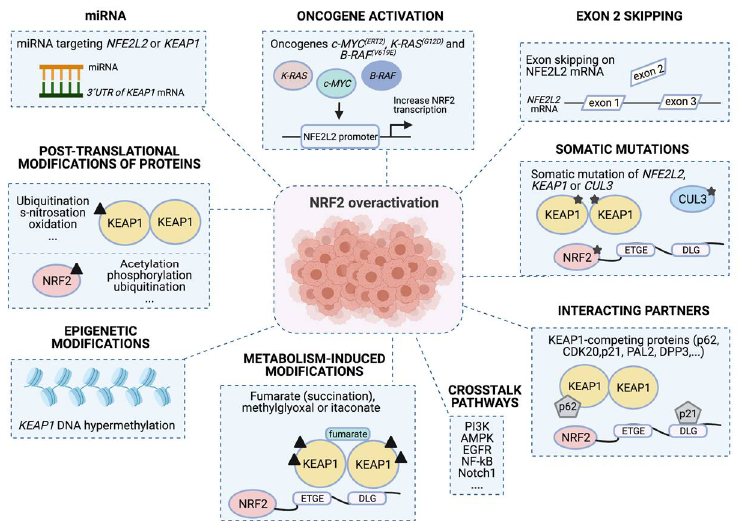
Figure 6. Molecular mechanisms confer NRF2 addiction. Different mechanisms can contribute to promote NRF2 over-activation. First, somatic mutations on NFE2L2/KEAP1/CUL3; second, differential slicing and loss of exon 2 during mRNA processing; third, mutations in other oncogenes, such as c-MYC (ERT2), K-RAS (G12D) and B-RAF (V619E) that increase NFE2L2 transcriptional levels. NRF2 can also be activated by: fourth, expression of different miRNAs that can regulate NRF2 and KEAP1 expression; fifth, post-translational modifications of NRF2 and KEAP1 that promote or suppress NRF2 activity; or sixth, epigenetic modifications, such as histone post-translation modifications in KEAP1 and NFE2L2 promoter regions that increase NRF2 accumulation. Finally, seventh: metabo- lites that can modify several residues in KEAP1, provoke NRF2 activation (metabolism-induced modifications); and eighth, NRF2 and KEAP1 interactions with other proteins (interacting partners) or pathways (crosstalk pathways) can also result in NRF2